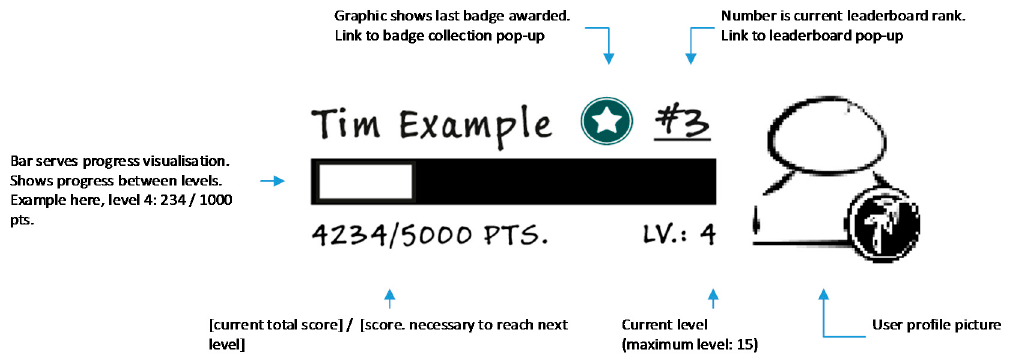
Figure A2. User platform–User profile